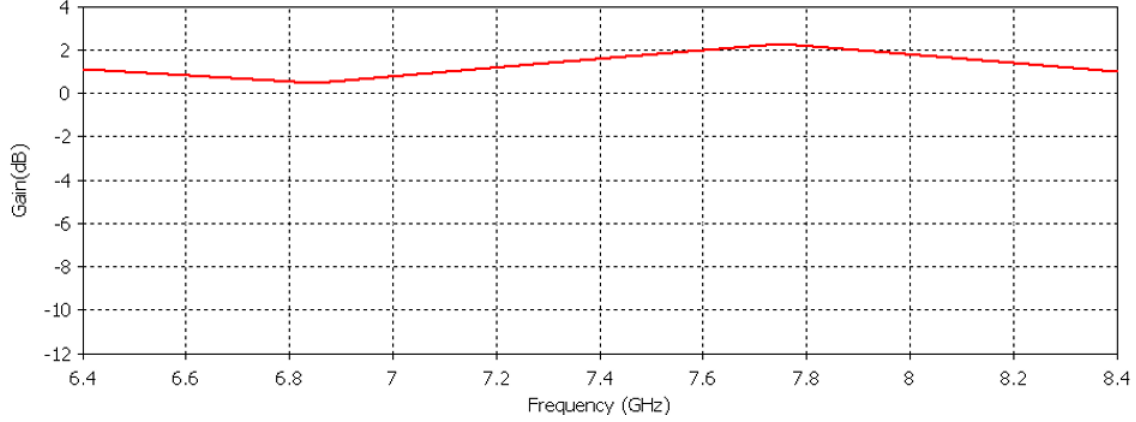
Figure 4. Variation of gain as a function of frequency for ground dimension 14 × 30 mm